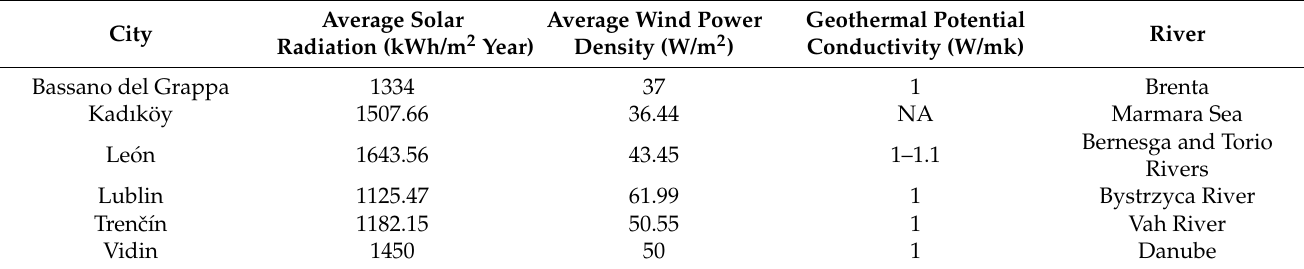
Table 16. Main characteristics of the renewable sources of the